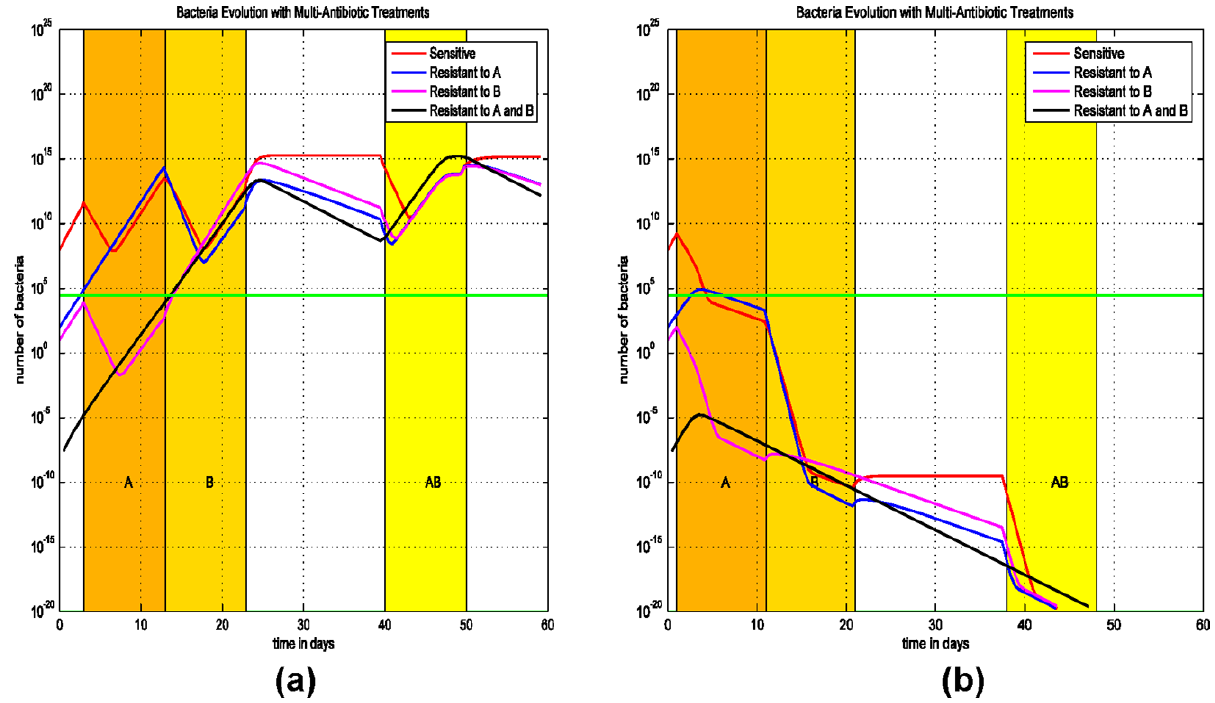
Figure 5. Simulations of Model (3) on sequential treatment with antibiotics A and B. (a) Treatment with antibiotic A starts at the 3 rd day after the infection and lasts for 10 days, right after that antibiotic B is administrated for 10 days, and at the 40 th day both antibiotics A and B are used for 10 days. (b) Same therapies except that the first treatment starts at the 1 st day after the infection.